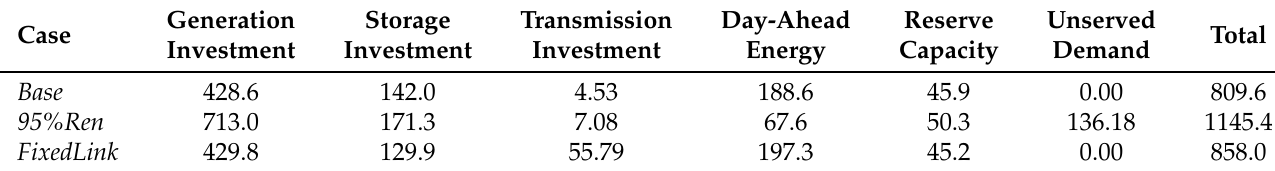
Table 11. Annualized expected costs (million e ).